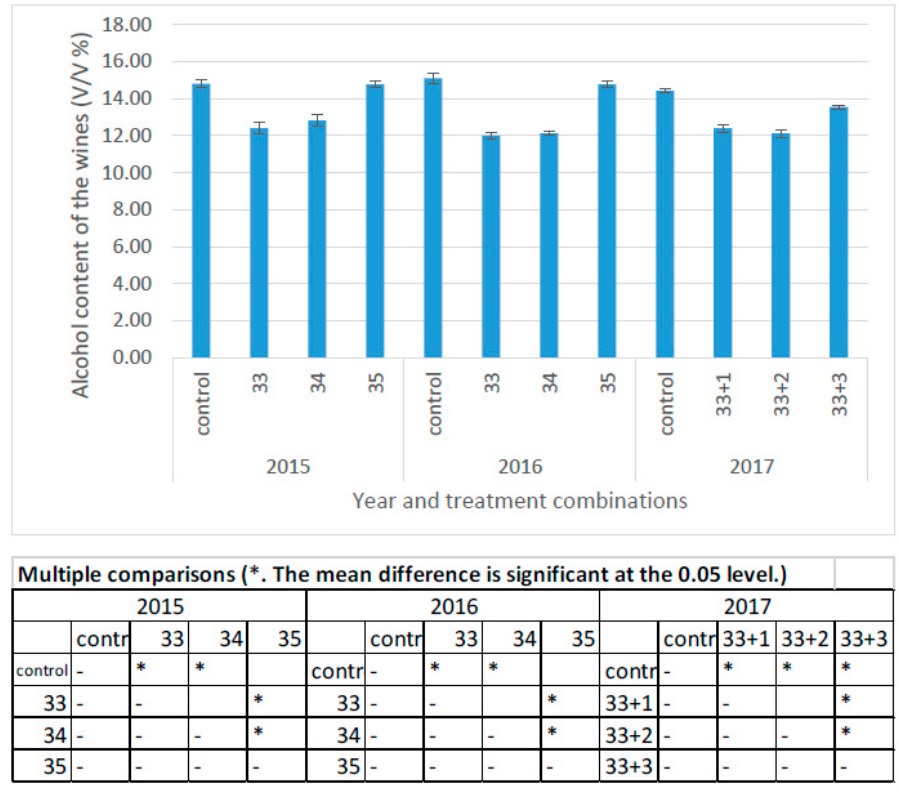
Figure 5. Alcohol content of the wines in 2015–2017 ( v / v %).